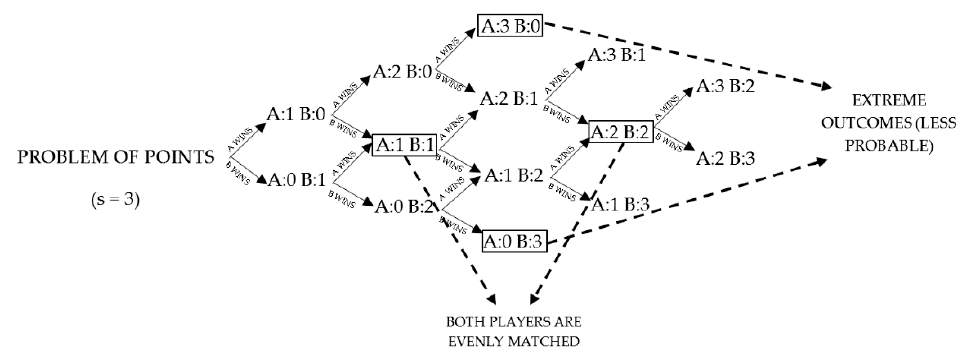
Figure 4. Problem of points for s = 3.